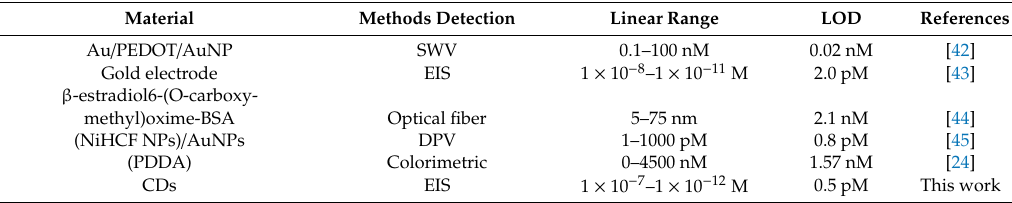
Table 1. Comparison of limit of detection (LOD) for some developed electrochemical biosensors, using 76 mer sequences E2